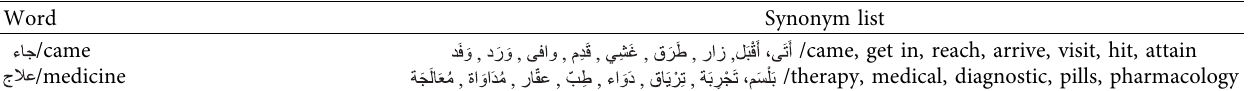
Table 6: Sample of the synonym lexicon.